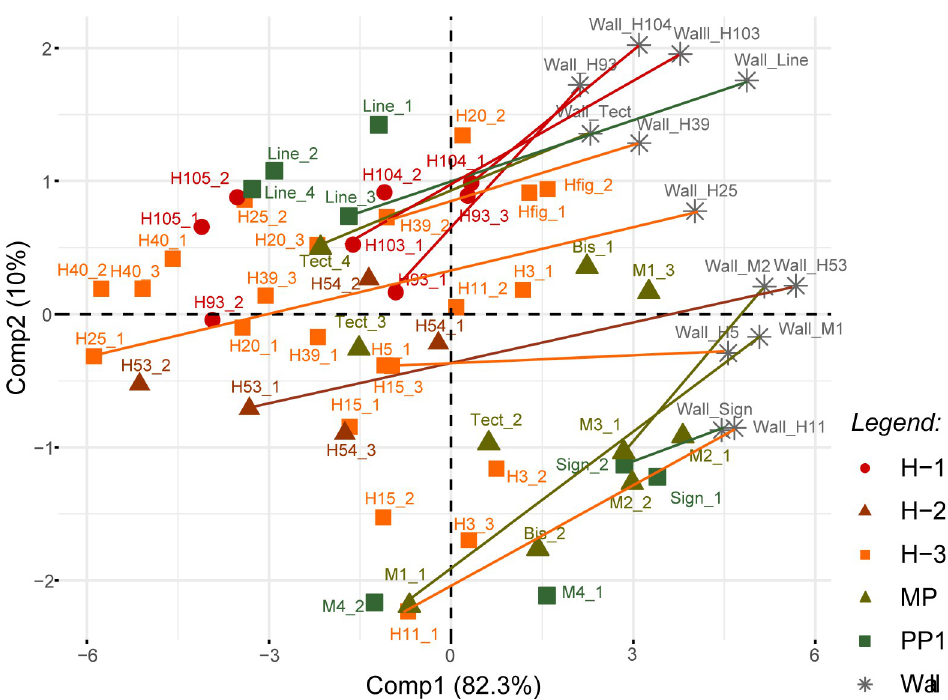
Fig 10. Results of PCAc of alr Fe-ratios of netto counts (peak areas), measurements ‘Exp2’, ‘wall-Exp2’ and ‘wall- red’ excluded. On the right: coordinates of individuals; on the left: coordinates of variables. The lines represent the vector of the ‘compositional’ distance between a painting and its